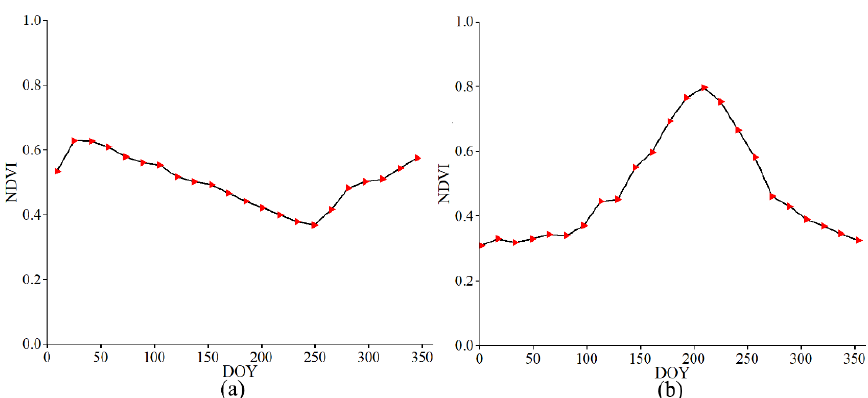
Figure 2. Time series of NDVI for study area ( a ) BAH and ( b ) NEA.